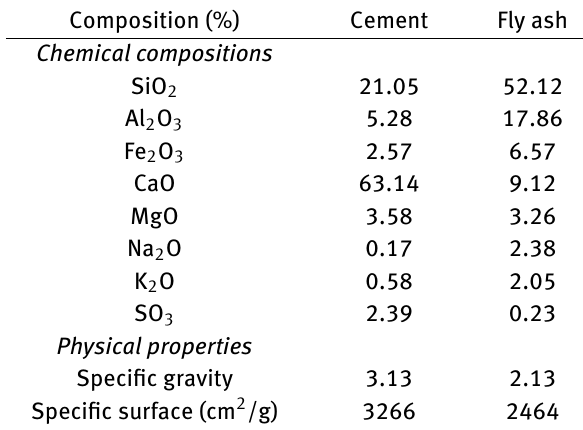
Table 1: Properties of cement and fly ash Composition (%) Cement Fly